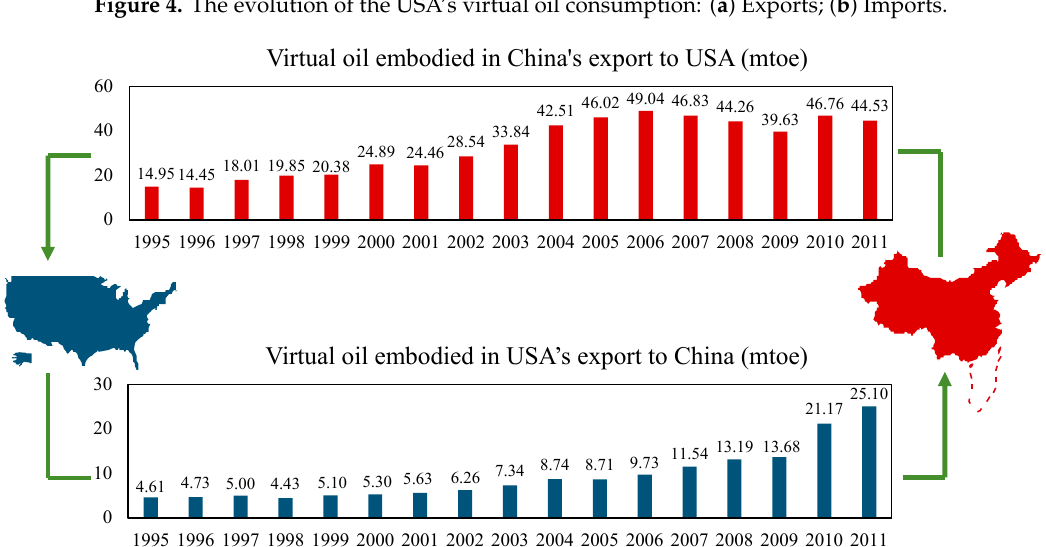
Figure 5. The virtual oil consumption embodied in Sino-US and its changing trend.